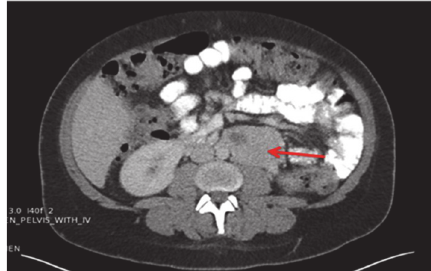
Figure 1: CT abdomen/pelvis demonstrating a left para-aortic mass measuring approximately 4.7 × 6.4